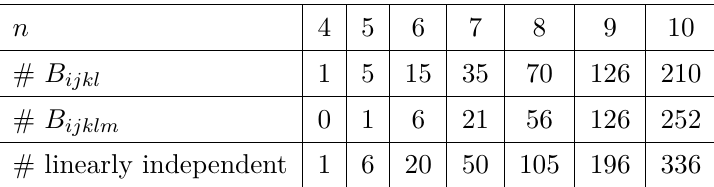
Table 1 . Counting of the linearly independent twistor functions (3.21) and (3.22) in the n -cusp case assuming the cyclic ordering of the indices. Conjecturally, these rational functions give a basis of the leading singularities R at any loop n